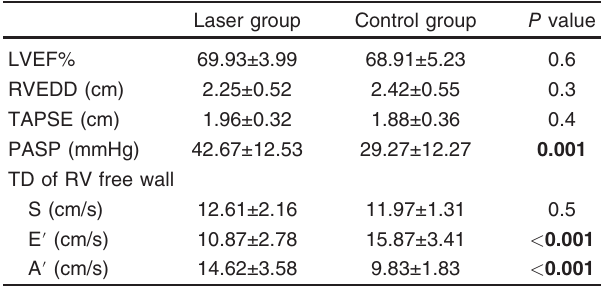
Table 4 Echocardiographic parameters at the end of the